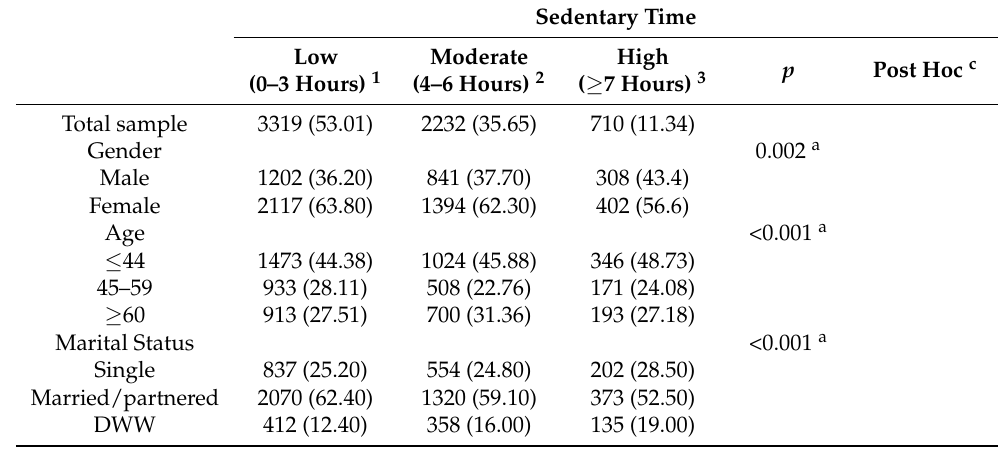
Table 5. Sedentary behavior of the population according to sociodemographic